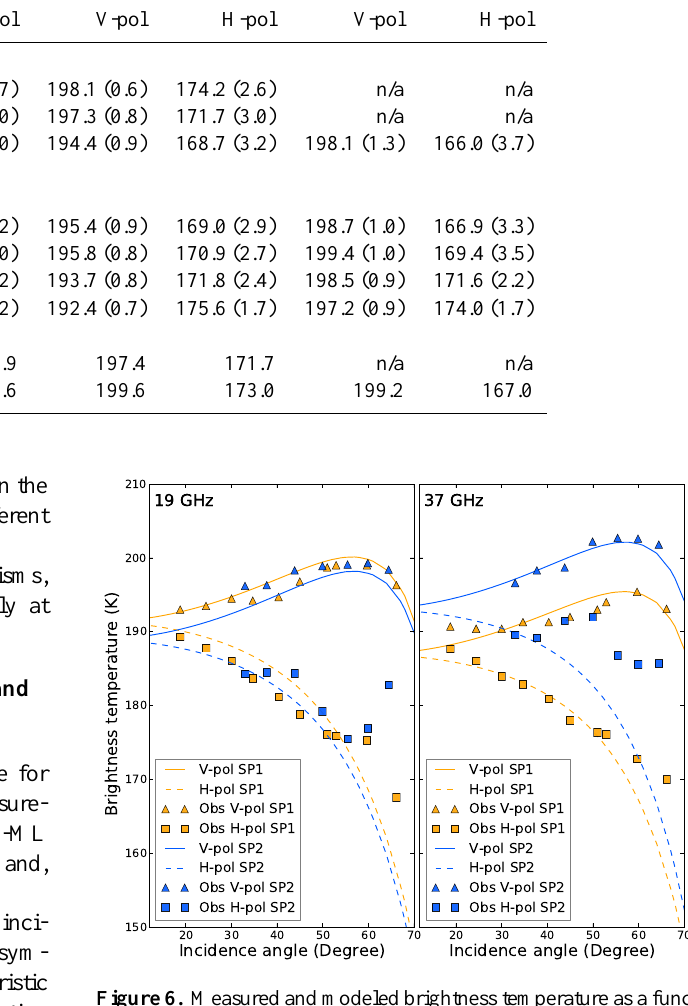
both locations, and the vertical polarization. Increasing φ by 0.1 results in a general decrease of 1.5–2.3 K depending on the angle and location. It means that the optimization of the φ factor is able to absorb any possible constant error in the cal- ibration of the radiometers, POSSSUM, density cutter, tem- perature, etc. However it could not modify the dependencies predicted by the model to the frequency, polarization and an- gle nor the differences between the two locations shown in Fig. 6. These dependencies and differences can thus be safely